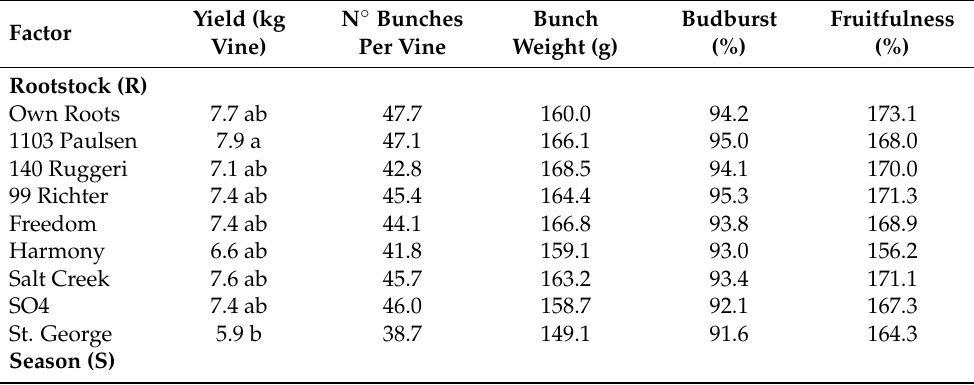
Table 3. Effect of rootstock on yield and its components of Syrah grapevines growing under hyper- arid conditions over five consecutive